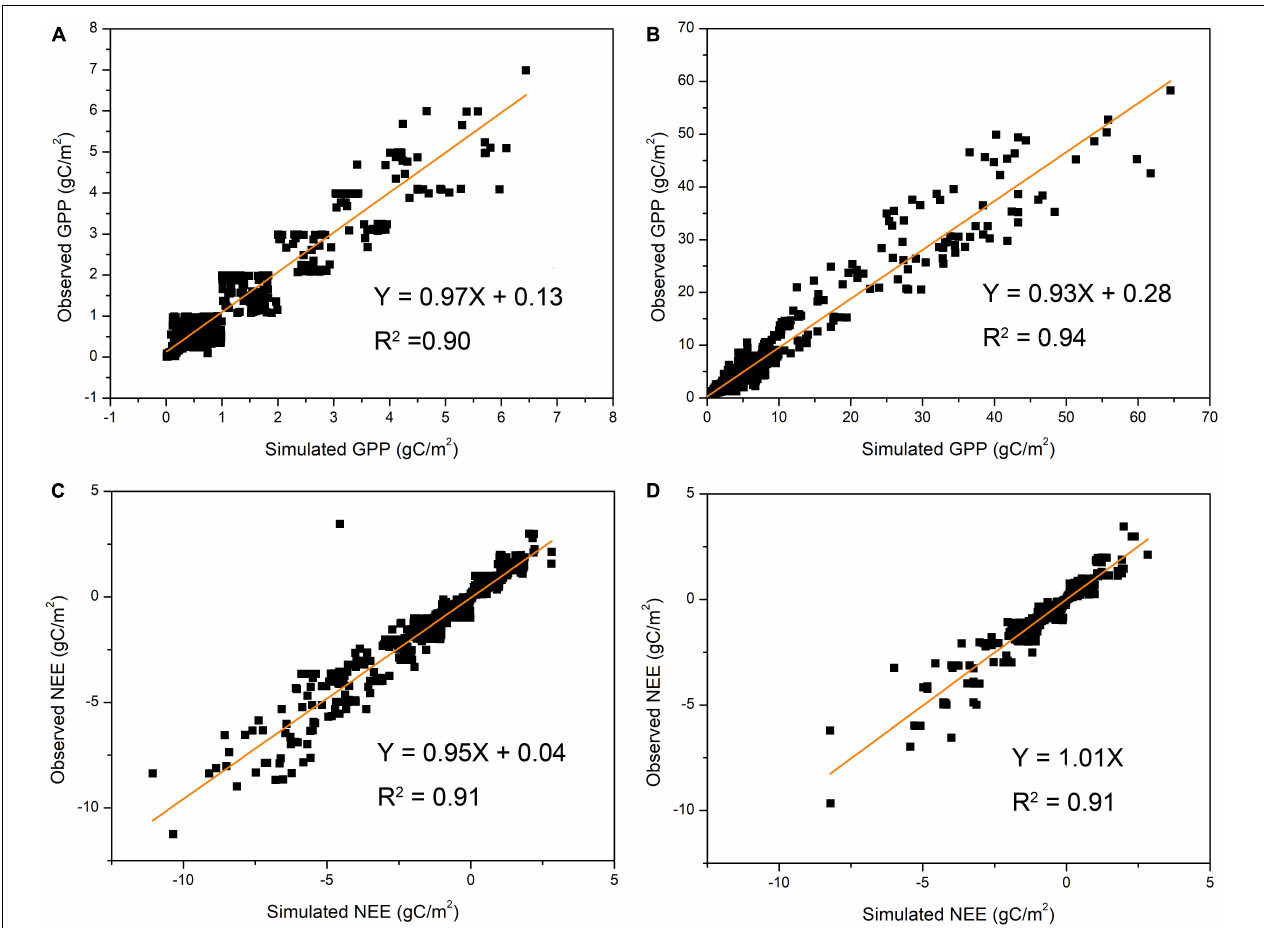
FIGURE 2 | Comparison of GPP values based on simulated and observational data under grazed (A) and ungrazed (B) conditions and NEE values under grazed (C) and ungrazed (D) conditions (GPP, gross primary productivity, NEE, net ecosystem